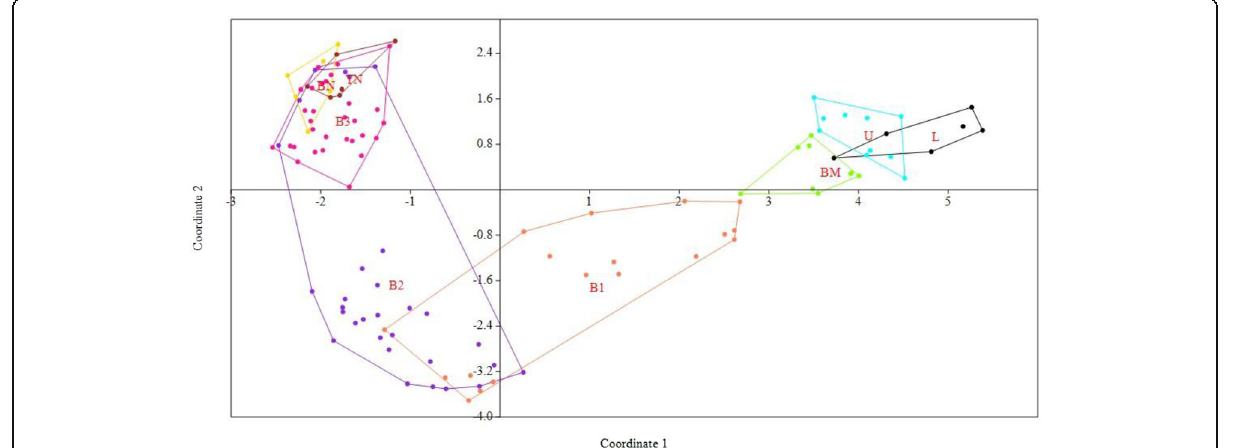
Fig. 9 Principal coordinate analysis (PCoA) revealing the clustering pattern of 8 populations (115 accessions) of I .